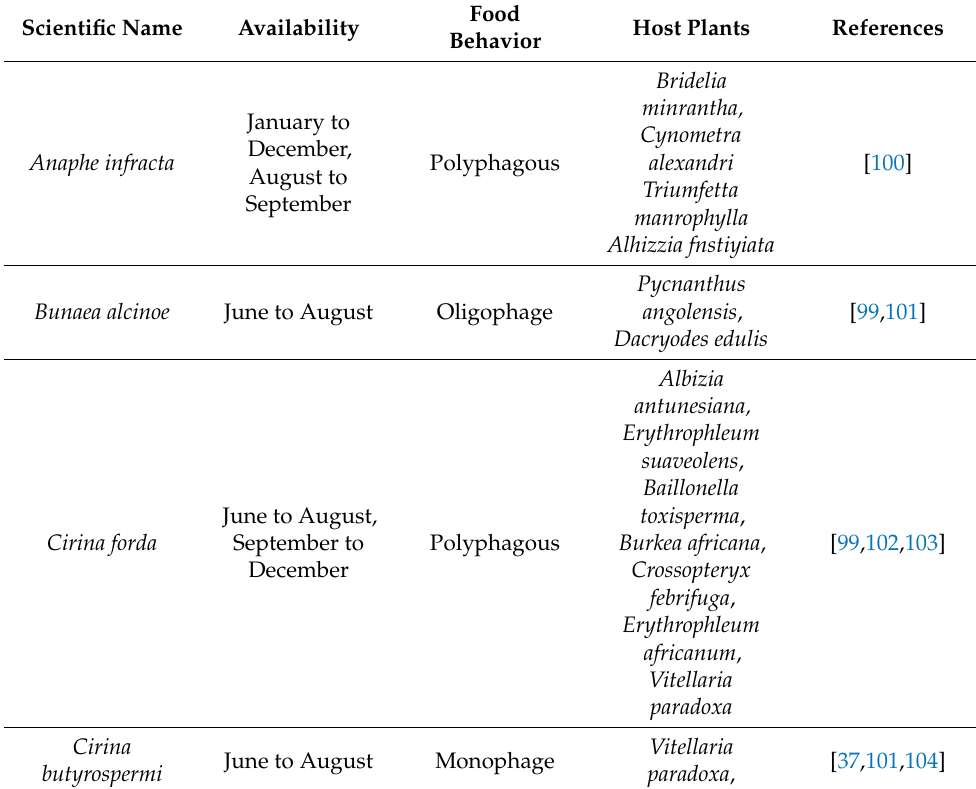
Table 7. Availability of edible caterpillars and their host